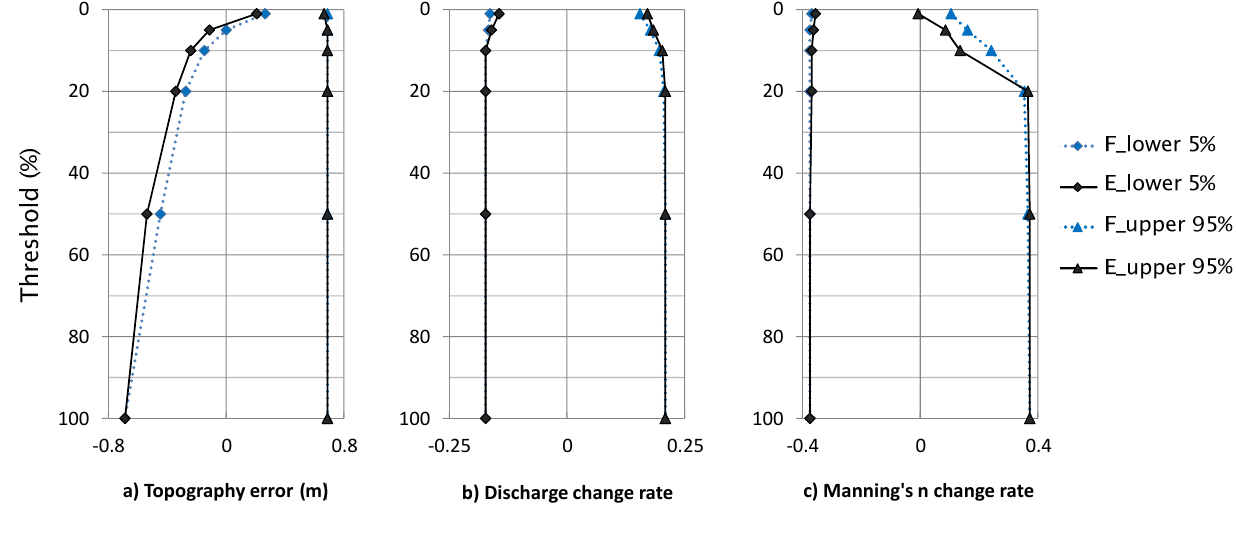
Figure 6. The ranges of model variables based on likelihood measures corresponding to 1%, 5%, 10%, 20%, 50% and 100% cut-off thresholds. ( a ) Topography error; ( b ) Discharge change rate; ( c ) Manning’s n change rate. (Note: the F and E indicate the F and E likelihood measures, respectively. The lower 5% and upper 95% are the lower 5% and upper 95% uncertainty bounds corresponding to the likelihood